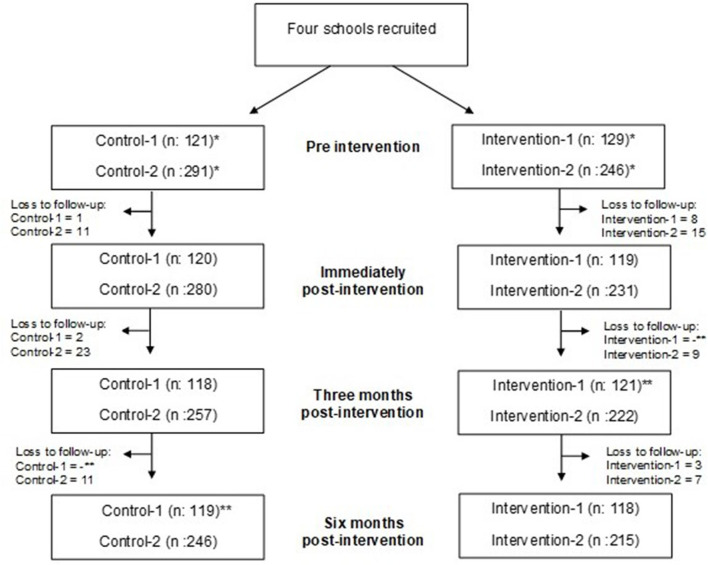
Flow chart of study participants in control and intervention groups at four time points. *Study final sample size: Missing data was dealt with using hot-deck imputation. **Participants missed a particular follow-up, and then returned in the study at the next follow.